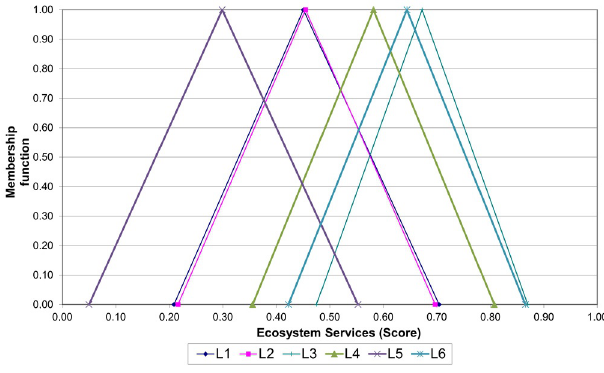
Figure 6. Landscape contribution to ES bene fi t.